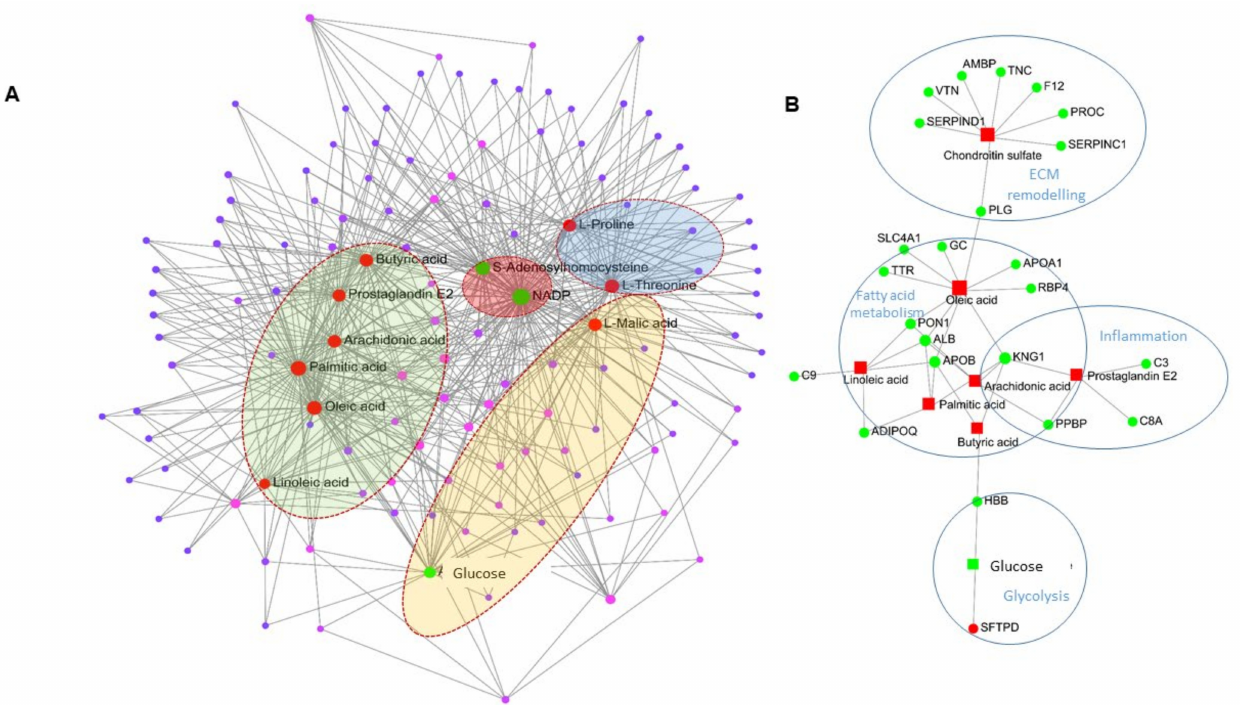
Figure 6. Interaction network analysis of the metabolites and proteins from metabolomics and proteomics. ( A ) Metabolite–metabolite interaction network for the most enriched metabo- lites in the upper lobe of PVB vs. Cntrl. Labeled and red-filled circles represent the upregu- lated metabolites, and green-filled circles represent the downregulated metabolites detected in the PVB group. Metabolites clustered in green background represent metabolites partici- pating in fatty acid metabolism, red background—ROS pathway; blue—ECM remodeling and yellow—glucose metabolism. ( B ) Gene–metabolite network analysis for the significantly altered proteins and enriched metabolites for upper lobe of PVB vs. Cntrl. The red-filled squares repre- sent the downregulated proteins, and green-filled circles represent the upregulated metabolites detected in the PVB group. Metabolites of VIP > 1 with p -value < 0.05 and proteins with fold change > 1.3 and Benjamini–Hochberg-adjusted p -value < 0.05 were used for the analysis. The proteins and metabolites belonging to one GO term are encircled